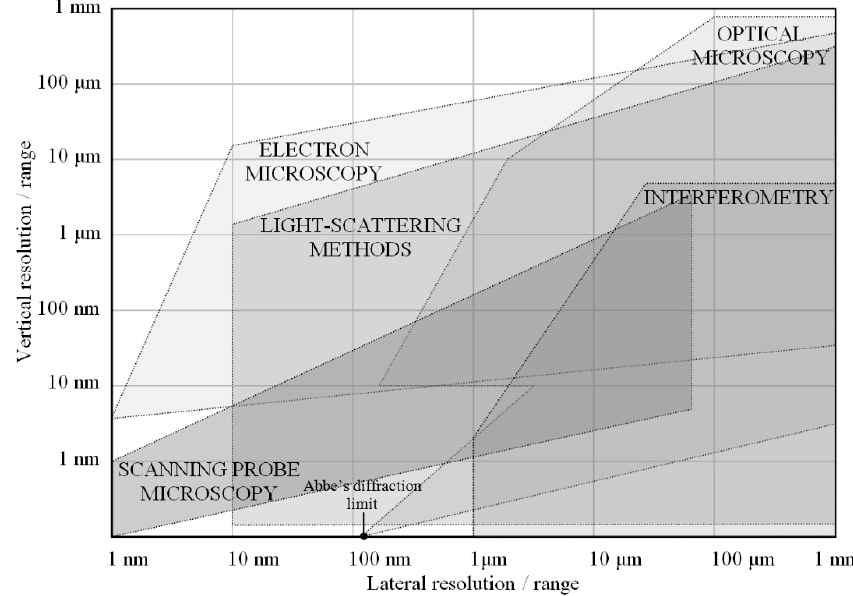
Figure 1. Approximate resolution ranges (horizontal and lateral) characterizing the modern advanced observation measuring non-contact methods used for assessment of surfaces after the polishing processes, modified based on [28].